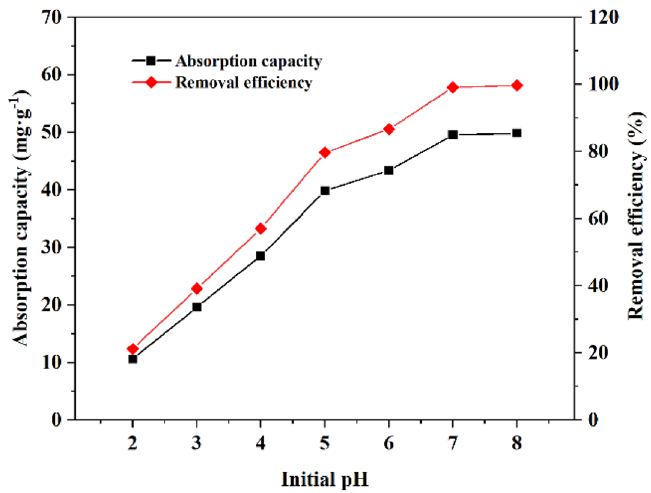
Figure 8. Effect of initial pH on the adsorption of Cd 2+ on MRM at T = 25 °C, dosage = 1 g L −1 , t = 240 min and initial Cd 2+ concentration = 50 mg L −1